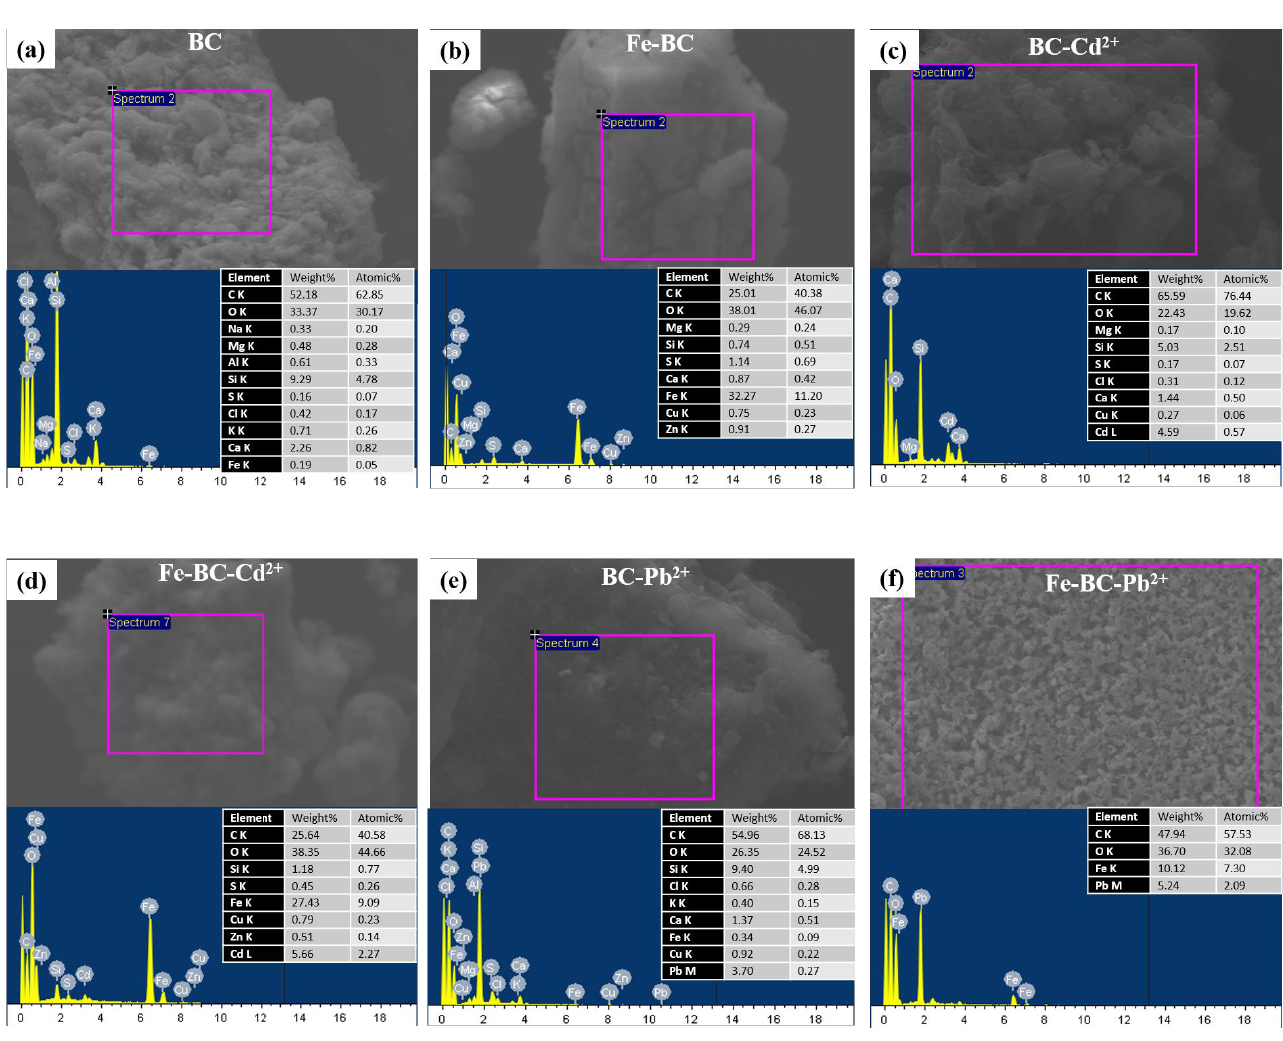
Figure 7. SEM – EDS analyses for ( a ) date palm waste biochar (BC), ( b ) Fe-modified biochar (Fe-BC) before the adsorption, and after the ( c ) adsorption of cadmium (Cd 2+ ) onto BC, ( d ) adsorption of Cd 2+ onto Fe-BC, ( e ) adsorption of lead (Pb 2+ ) onto BC, and ( f ) adsorption of Pb 2+ onto Fe-BC.